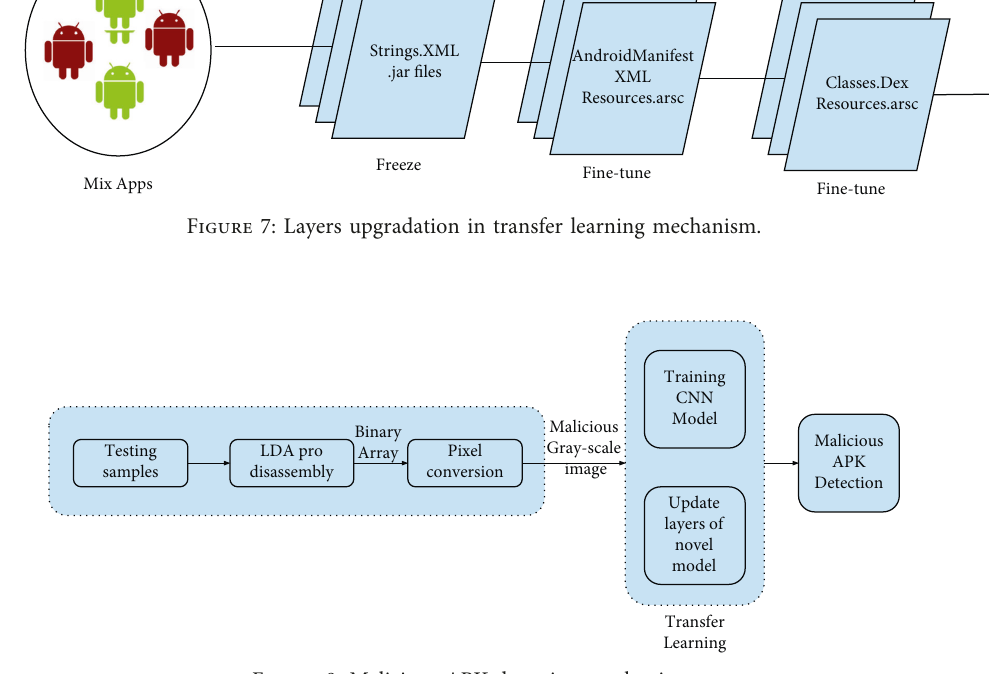
Figure 8: Malicious APK detection